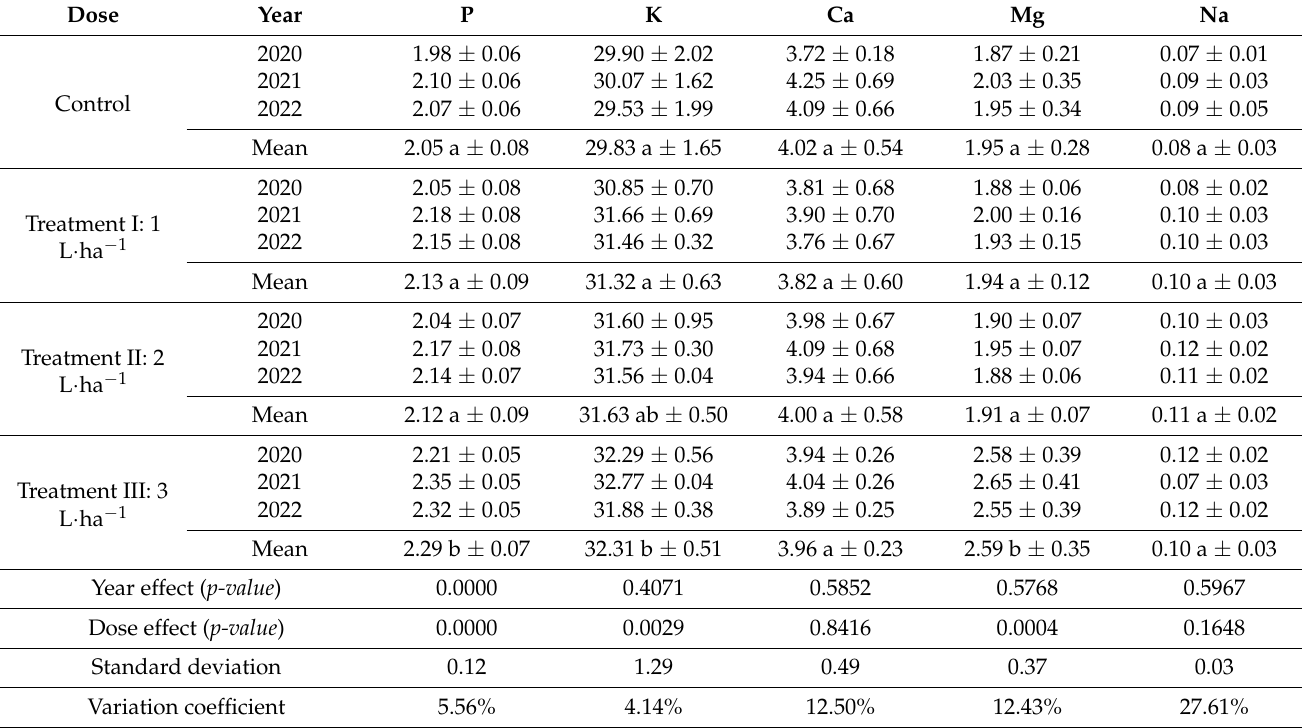
Table 8. Effect of mineral-organic multi-component fertilizer application on the macroelement content in plants (g · kg − 1 d.m.).